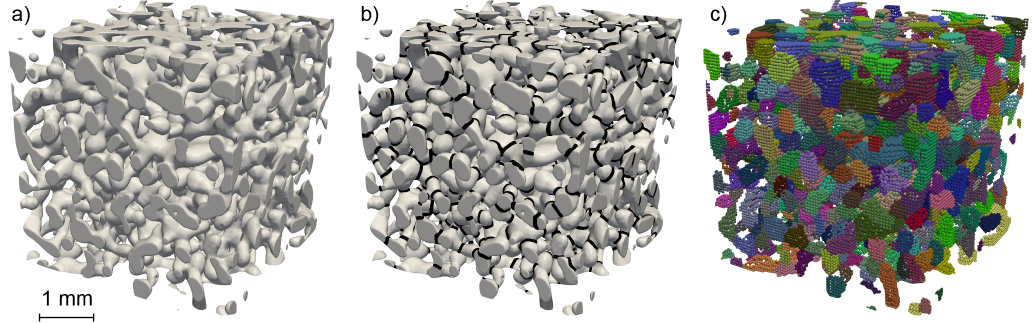
Figure 2. Granular description of the ice matrix. The binary image (a) is segmented into grains (b) separated by bonds (in black). The grains detected are themselves represented as clumps of spheres (c) .